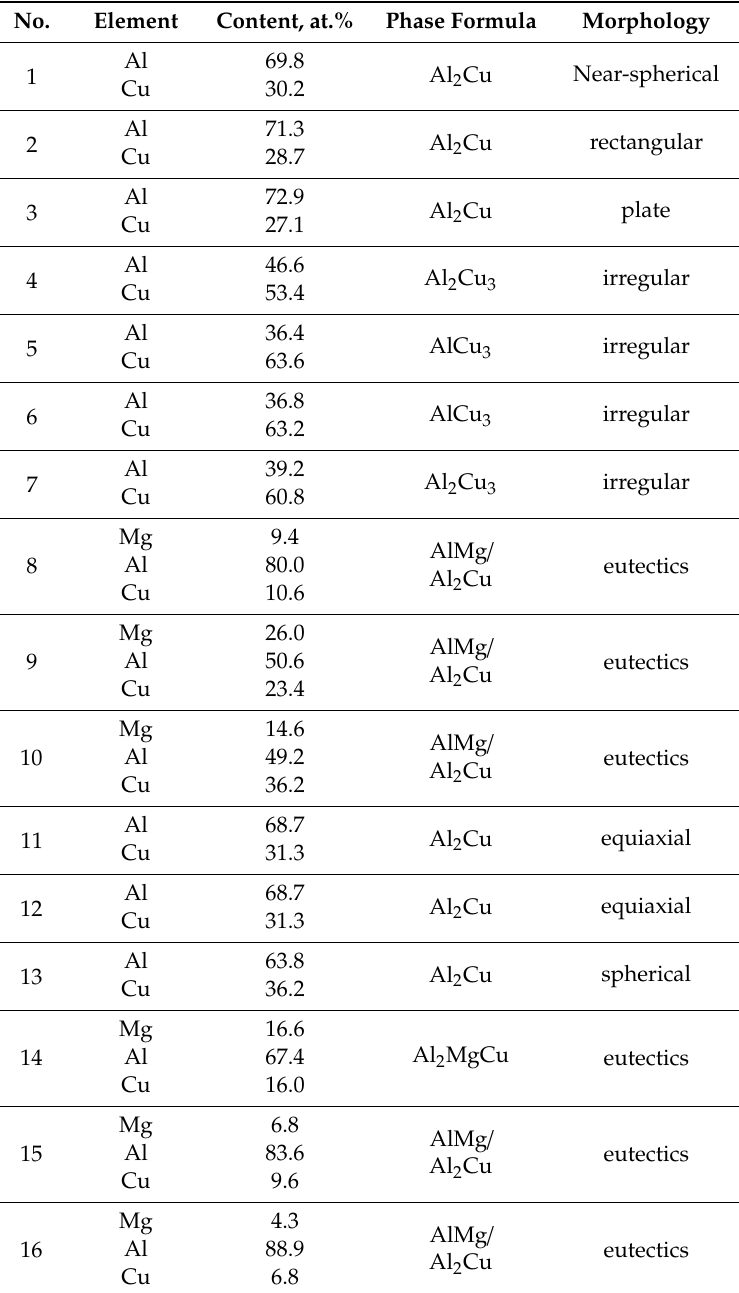
Table 2. Chemical compositions of phases shown in Figure